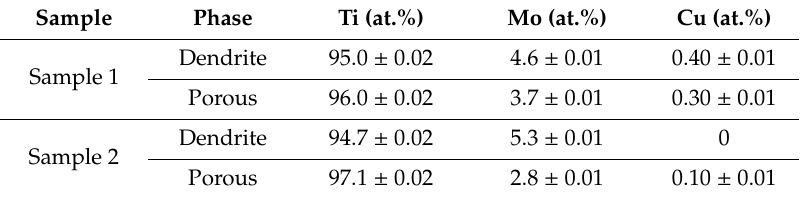
Figure 3. Elemental distribution maps of the porous TiMo alloy samples obtained by dealloying at 800 °C for 10 min ( right panel) and 900 °C for 5 min ( left panel). Table 1. Chemical composition of the porous TiMo samples.